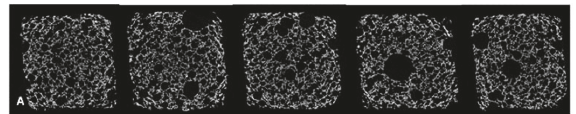
Figure 1: X-ray microtomography 2D reconstructed cross section images of cake samples [11].